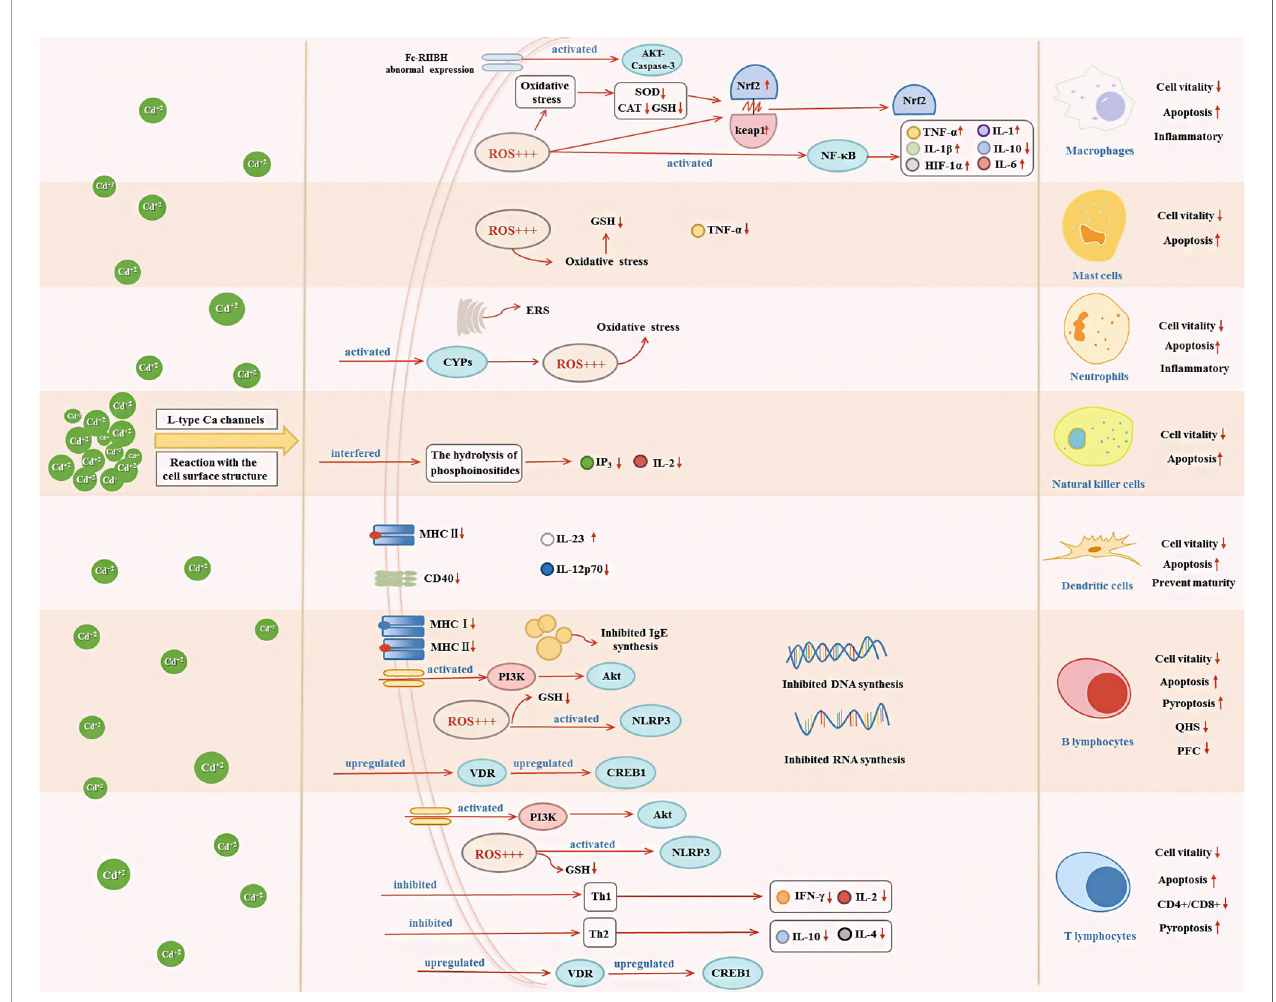
FIGURE 2 | Effects of Cd exposure on innate immune and adaptive immune cells and their underlying mechanisms. Cd ions can enter cells through Ca channels of the L-type or react with surface structures of the cell. After entering the cell, Cd will affect the secretion of immune cytokines through activating oxidative stress, ERS, NF- k B, VDR/CREB, NLRP3, CYPs, and PI3K/Akt signaling pathway, which in turn decrease cell vitality and induce